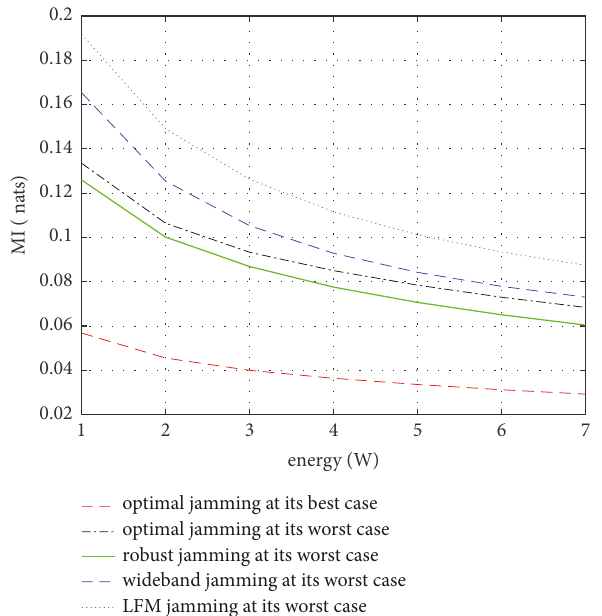
Figure 11: Waveform results for single target.